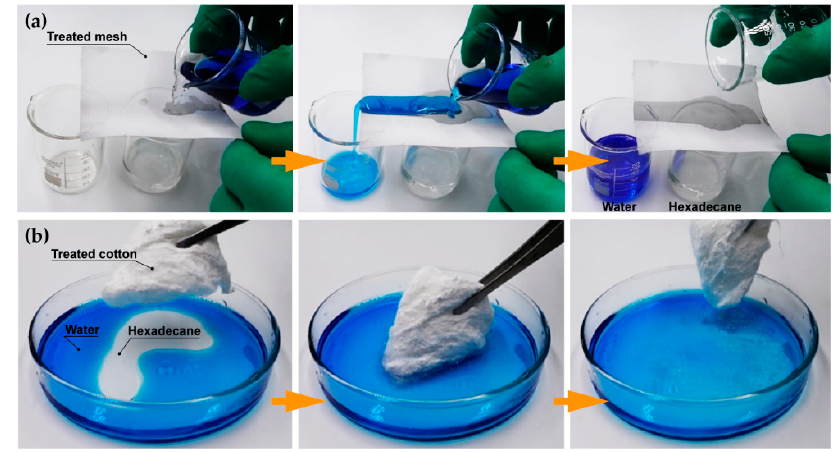
Figure 3. Demonstration of separating a hexadecane/water mixture with ( a ) spray-treated mesh and ( b ) soak-treated cotton. Water was dyed blue for ease of observation.